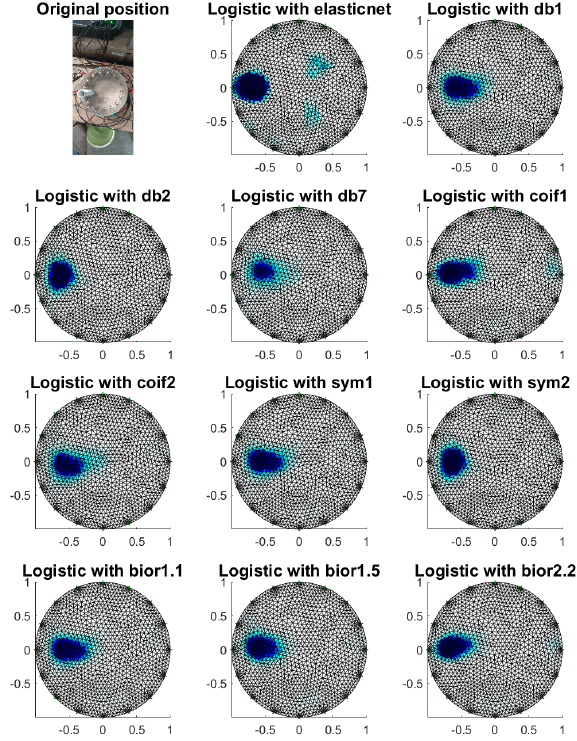
Figure 14. Image reconstruction with a phantom at electrode 13.